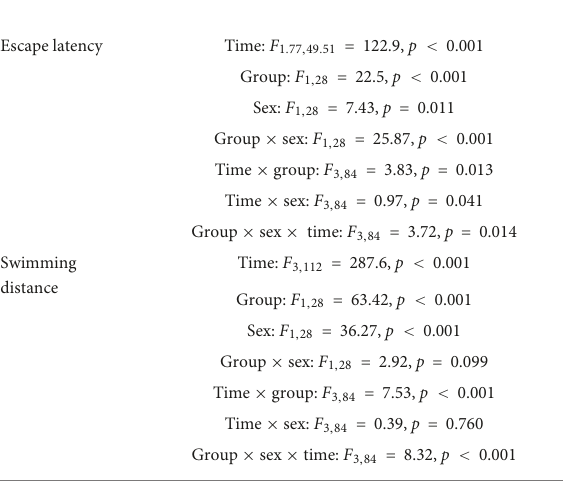
TABLE 4 Detailed statistics of three-way ANOVA in the training trials of MWM test. Three-way RM ANOVA (Group × sex ×